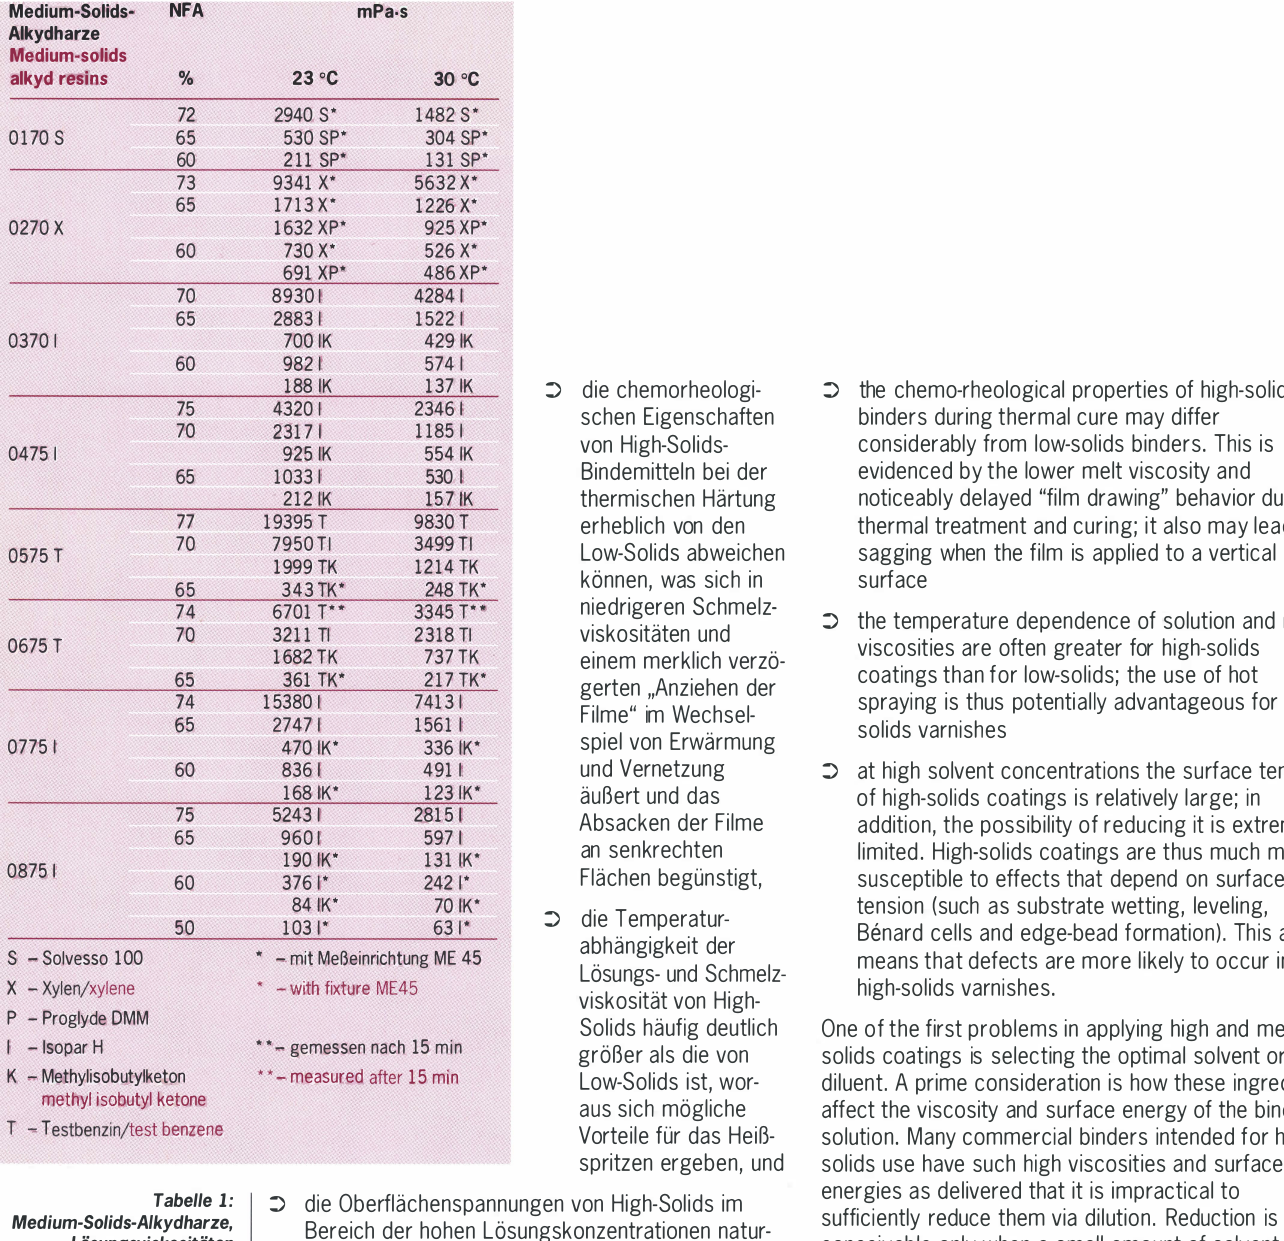
Tabelle 1: Medium-Solids-Aikydharze, Losungsviskositaten in verschiedenen Table 1: Medium-solids alkyd resin solution viscosities in various